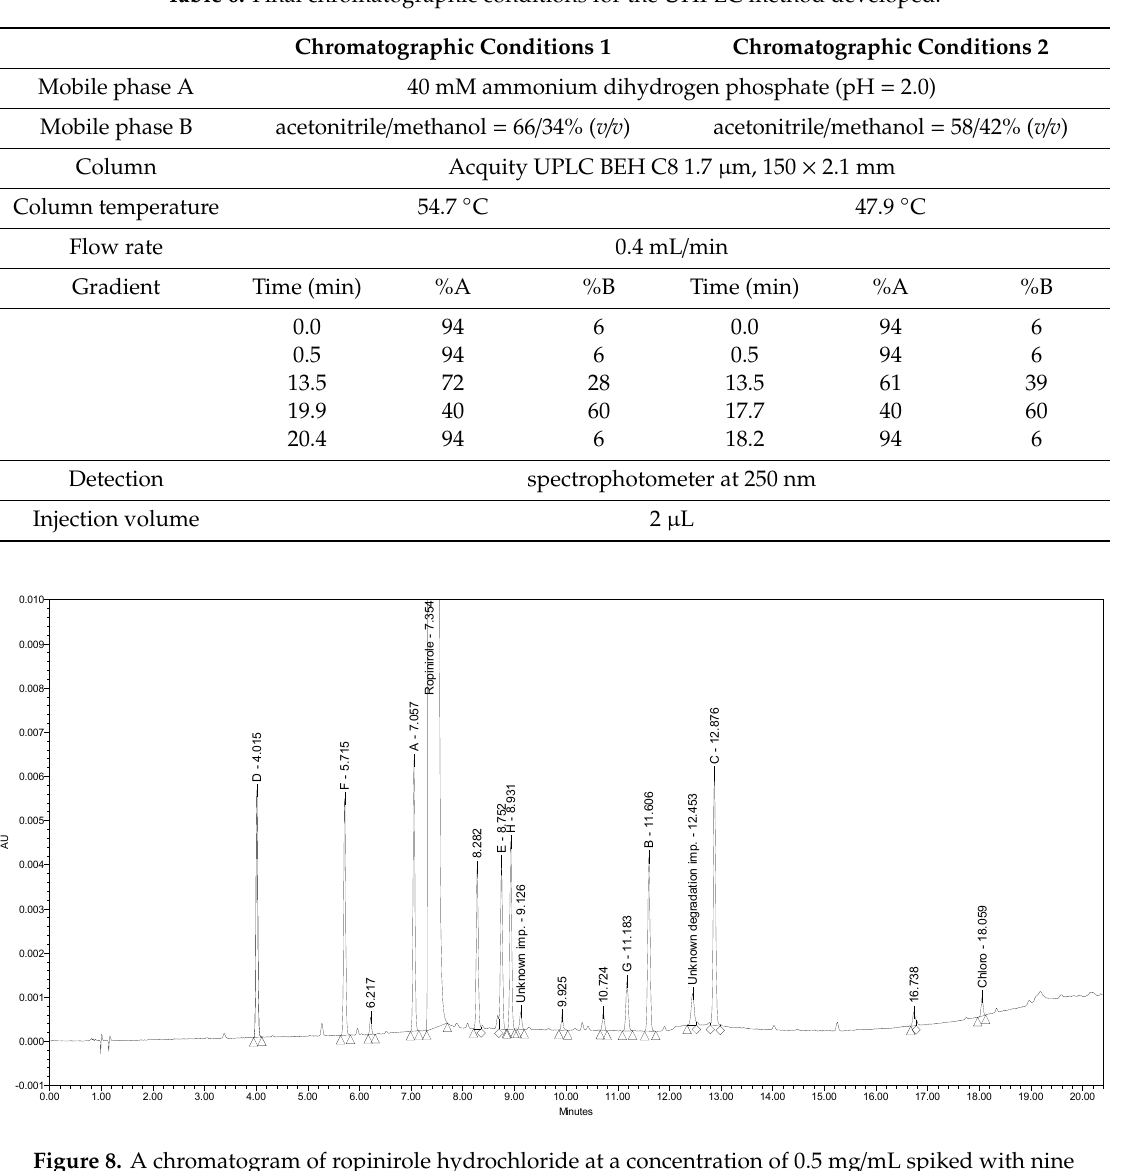
Figure 9. A chromatogram of ropinirole hydrochloride at a concentration of 0.5 mg/mL spiked with nine process-related impurities at the 0.2% level, including unknown impurity present in the sample (t R ≈ 8 min) and unknown degradation impurity (t R ≈ 11 min), obtained using chromatographic conditions 2. Applying the AQbD approach, two method robustness regions were obtained. This means that the analyses can be performed using parameter settings of either the first or second method. Based on a wider robustness area (approximately three times wider), we used optimal chromatographic conditions 1 to perform method validation. In addition, method robustness region 1 was also confirmed experimentally by performing 8 (= 2 3 ) experimental runs according to a full factorial screening design. The CMA criteria were confirmed in each experimental run. 2.7. Method Validation